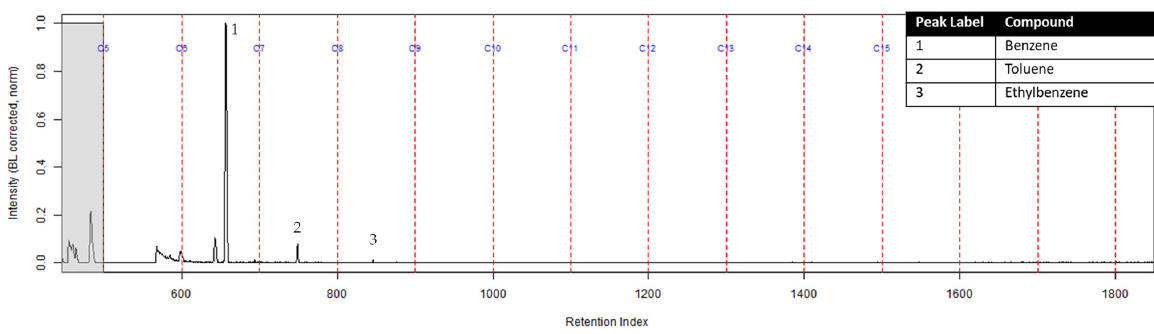
Figure 8. Zoomed TIC of the CS 2 extract from the activated charcoal strip within the dosimeter containing the ACL from the can containing 2-min MDDM burned vinyl siding and a railroad tie (maximum peak abundance 1.2 × 10 6 ).